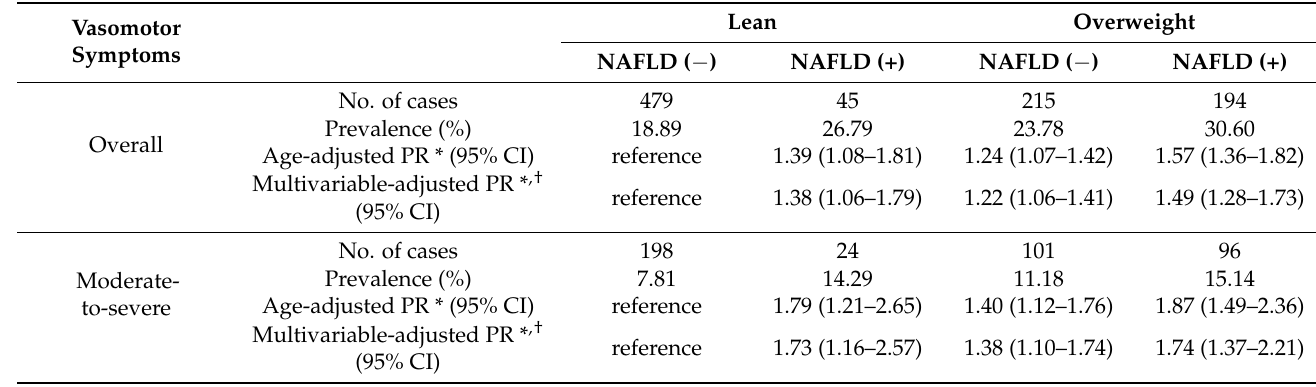
Table 2. Cross-sectional association between nonalcoholic fatty liver disease and vasomotor symp- toms in lean and overweight premenopausal women ( n =